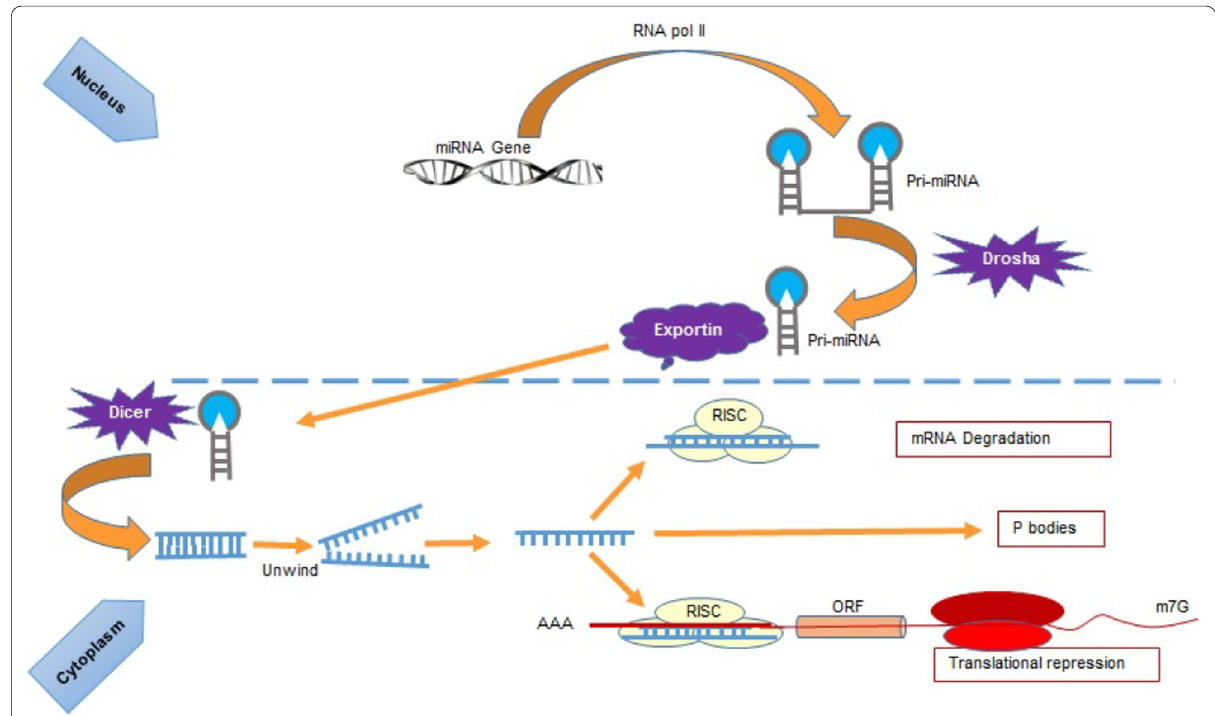
Fig. 1 Gene silencing procedure by